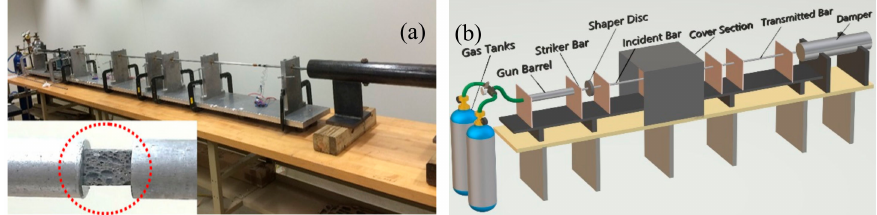
Figure 3. ( a ) SHPB (Split Hopkinson Pressure Bar) apparatus applied in the confront investigation as viewed from the transmitter bar end and foam specimen between the incident and transmitted bar shown in under doted circle; ( b ) major components of